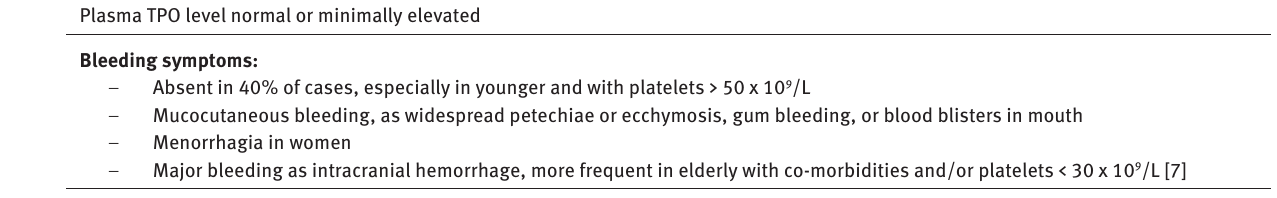
Table 1: Criteria for diagnosis of ITP [4-5] Platelet count < 100 x 10 9 /L Presence of circulating antiplatelet antibodies